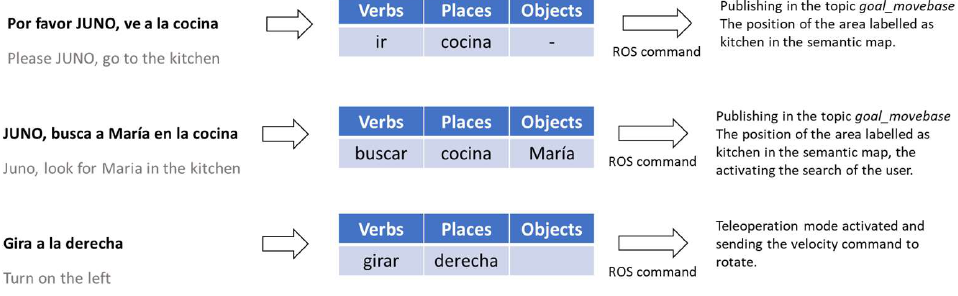
Figure 14. Example of sentences understood by the robot.